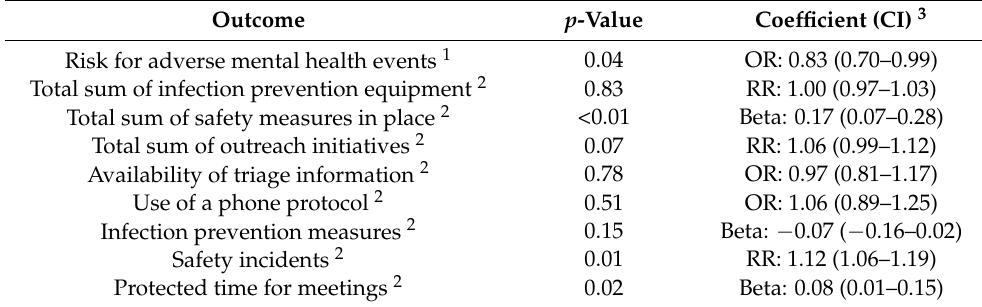
Table 4. Effect of being a training practice on selected